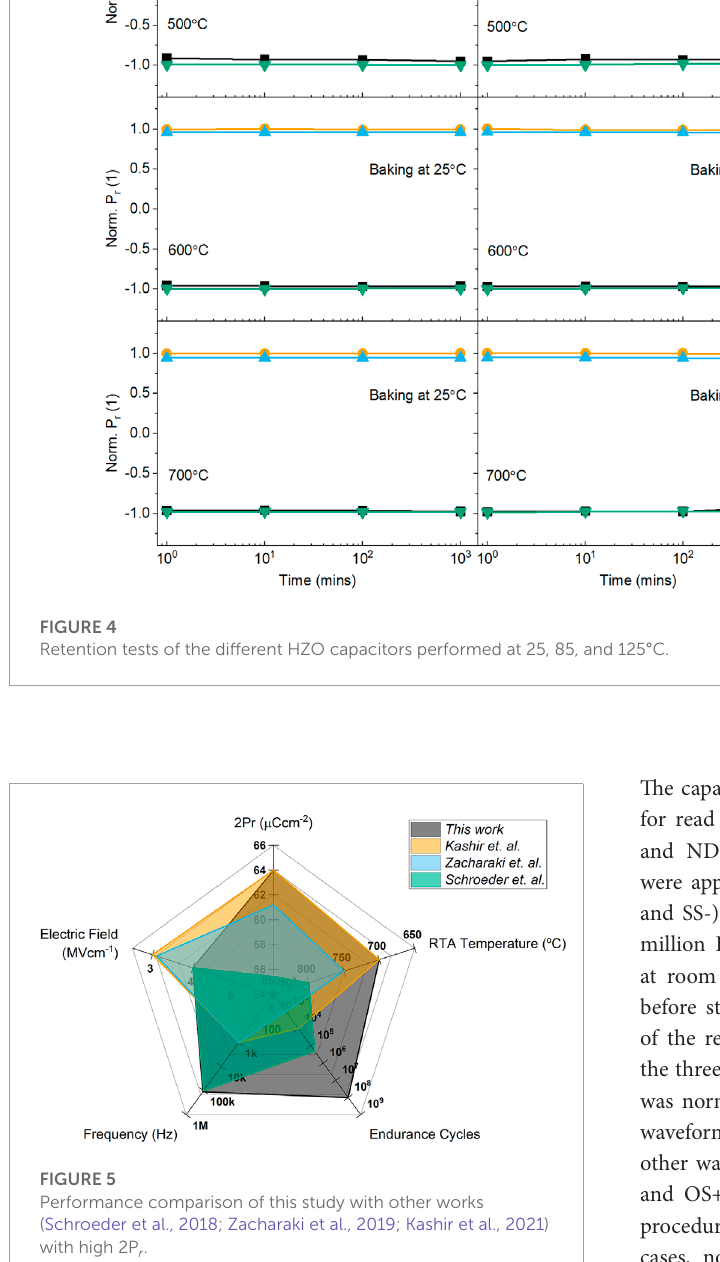
capacitors were still switchable after 10 10 cycles, even under a fast-testing